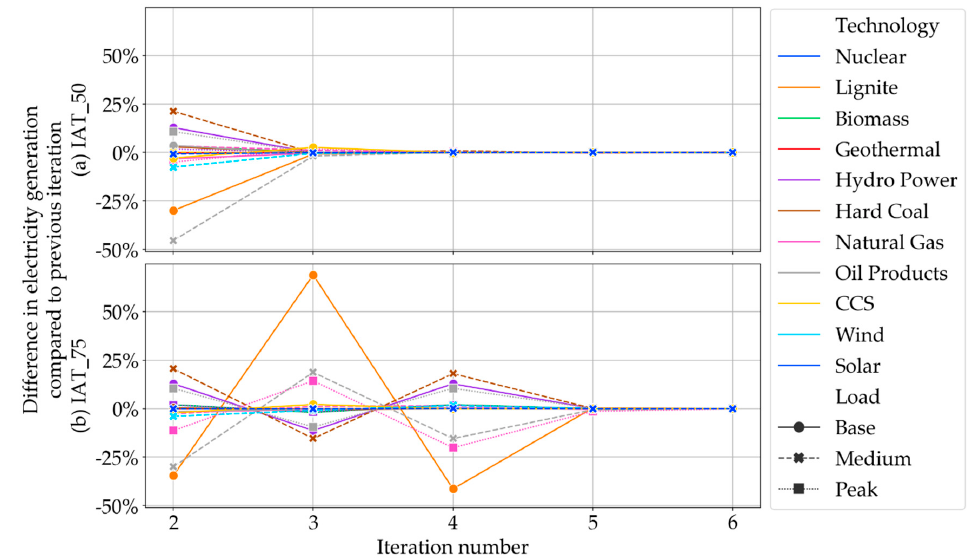
Figure 8. Difference (%) in electricity generation in the EU28 compared to previous iteration for (a) IAT_50 and (b) IAT_75 in 2050.